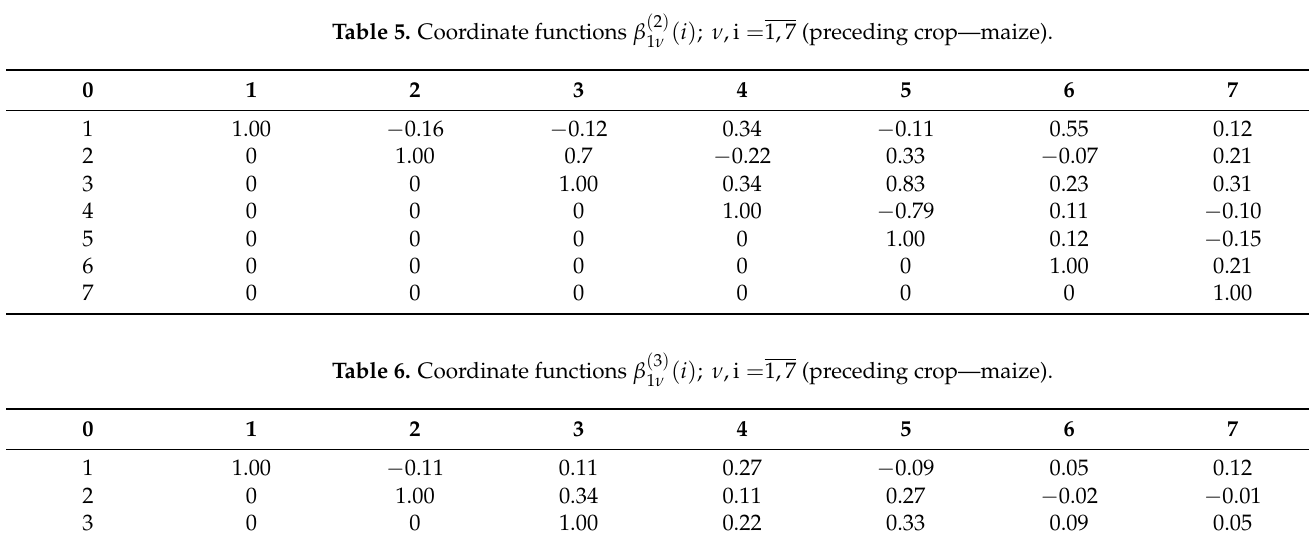
Table 5. Coordinate functions β